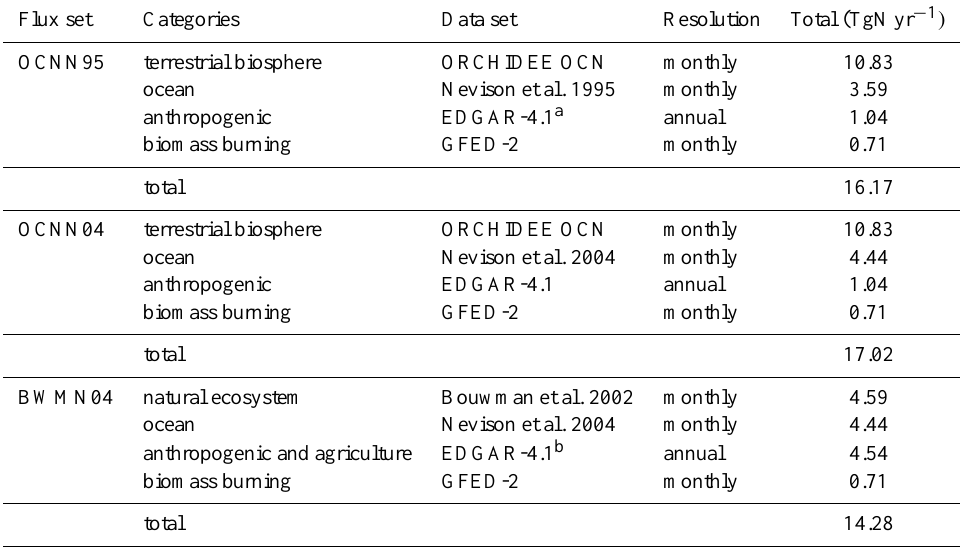
Table 3. Overview of the additional prior fluxes (totals shown for